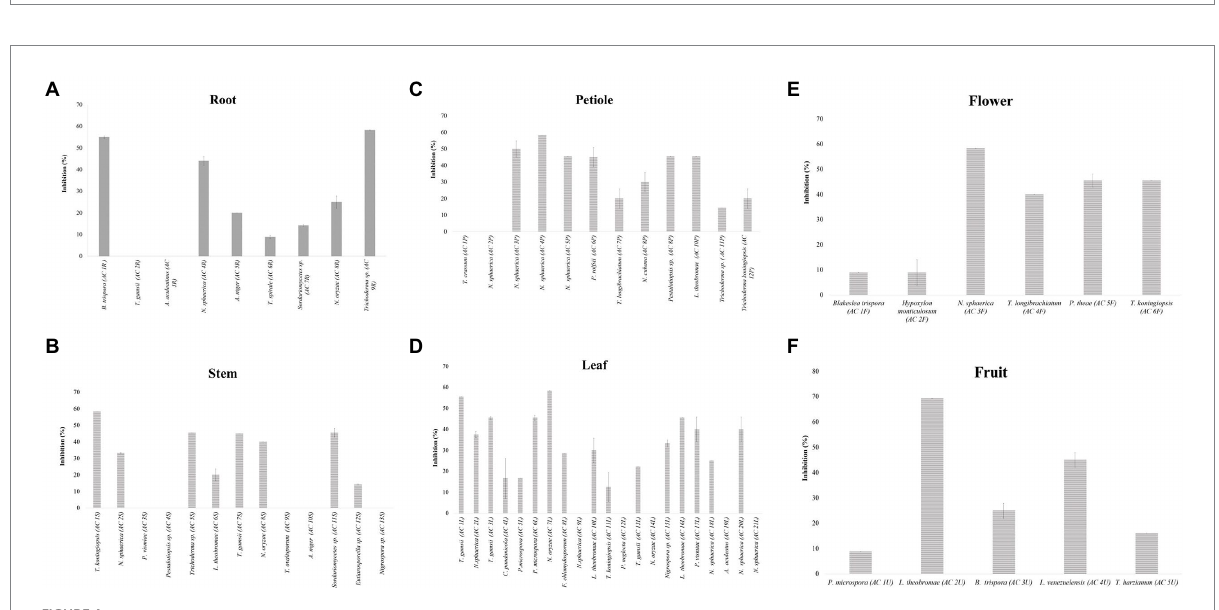
FIGURE 4 The inhibition percentages (I%) of endophytic fungi isolated from root (A) , stem (B) , petiole (C) , leaf (D) , flower (E) , and fruit (F) against the pathogen Ceratocystis fimbriata . Data are mean ± standard error (SE) of triplicates. Means followed by the same letter in each group are not significantly different at α = 0.05 according to